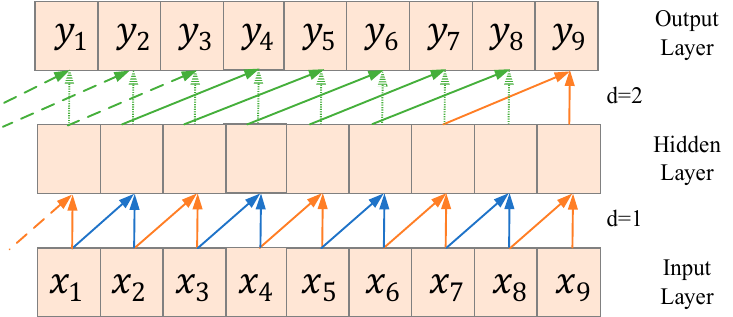
Figure 2. The structure of dilated causal convolutions.